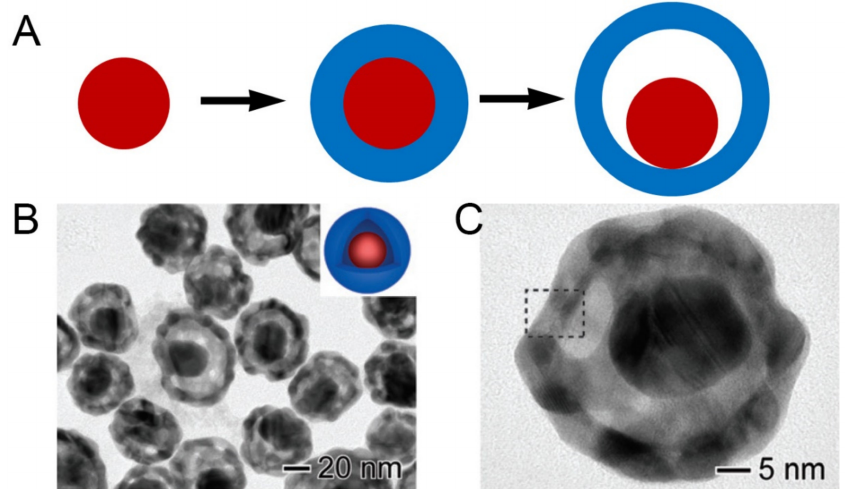
Figure 2. Self-templating syntheses for yolk–shell nanostructures. ( A ) Scheme illustrating the procedure for the Au core and Au / Ag alloy shell through the galvanic replacement reaction. ( B , C ) TEM images of Au@Au / Ag yolk–shell nanostructure. Reproduced with permission from [37]. Copyright Wiley-VCH, 2016.